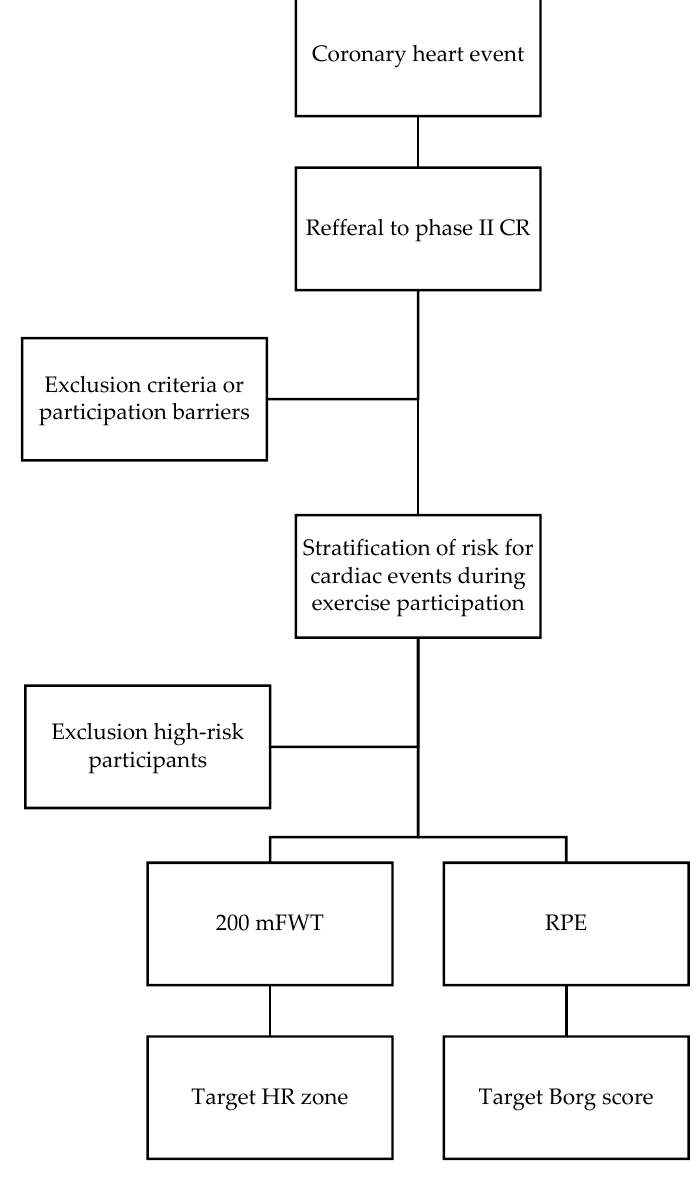
Figure 1. Decision flow chart.